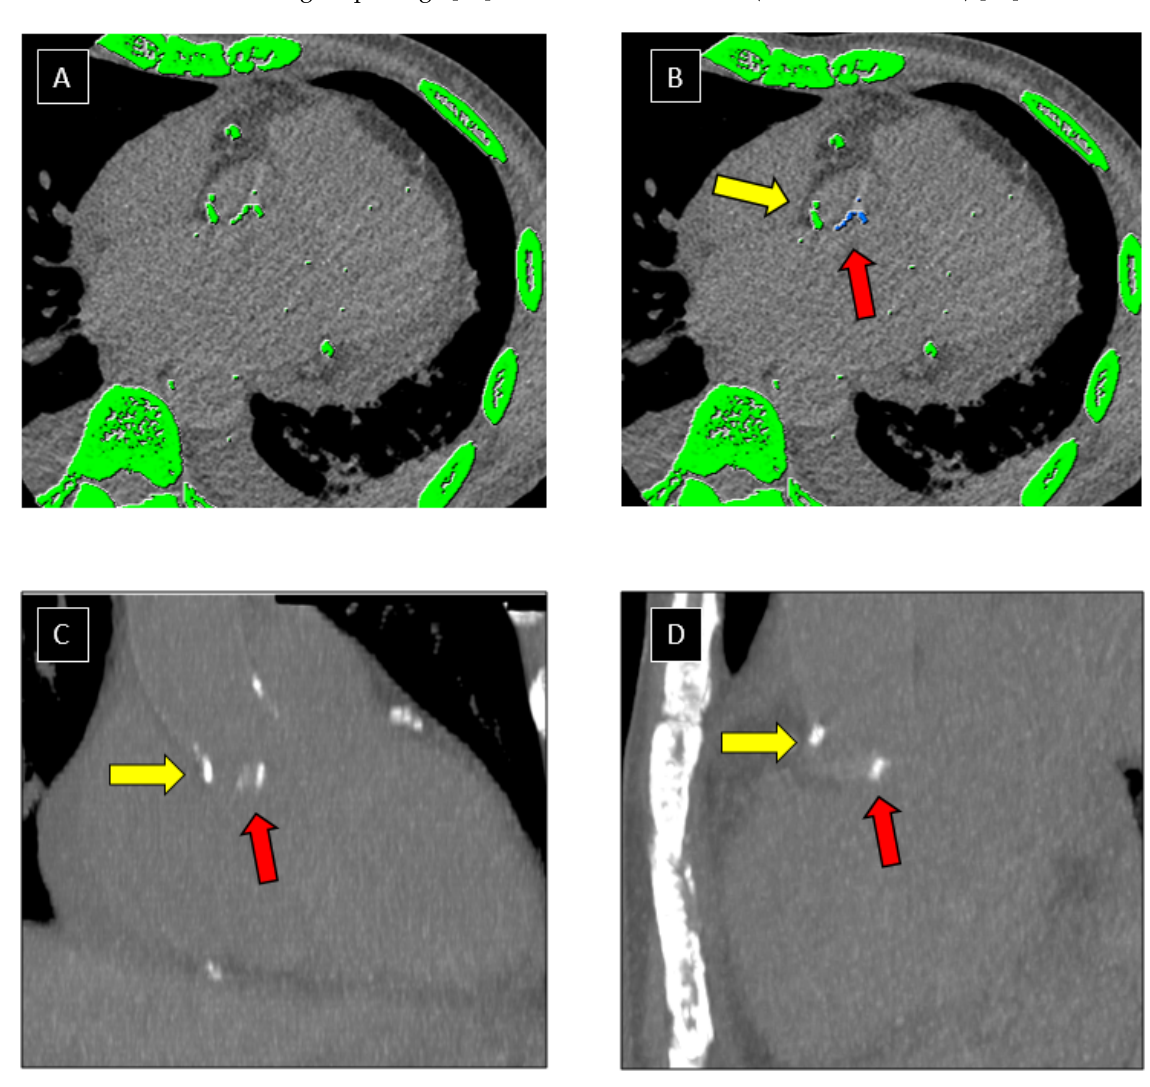
Figure 2. Post processing of CCT images. Example of segmentation of aortic valve calcifications on CT images using a dedicated software. Automatic detection of structures with a density > 130 Hounsfield Units (highlighted in green) was performed by the software on axial CT images ( A ). Valve calcifications (red arrow) were manually selected by the operator and appeared as blue pixels after selection ( B ). Attention was paid not to include aorta calcifications (yellow arrow) in the selection. Multi-planar-Reformation technique ( C and D ) was used to improve distinction between aortic (yellow arrow) and valve (red arrow) calcifications.